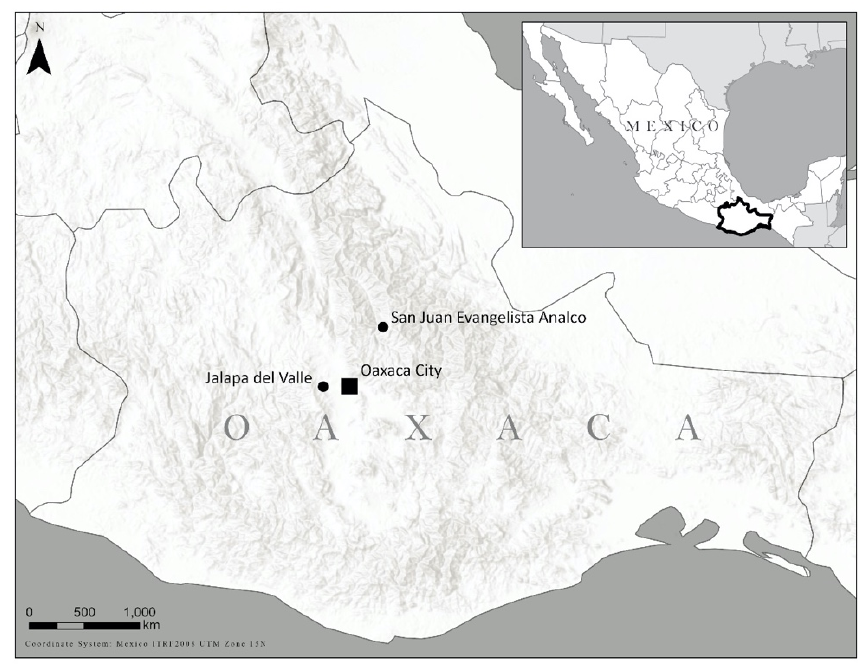
Figure 1. Location of study communities in Oaxaca, Mexico.